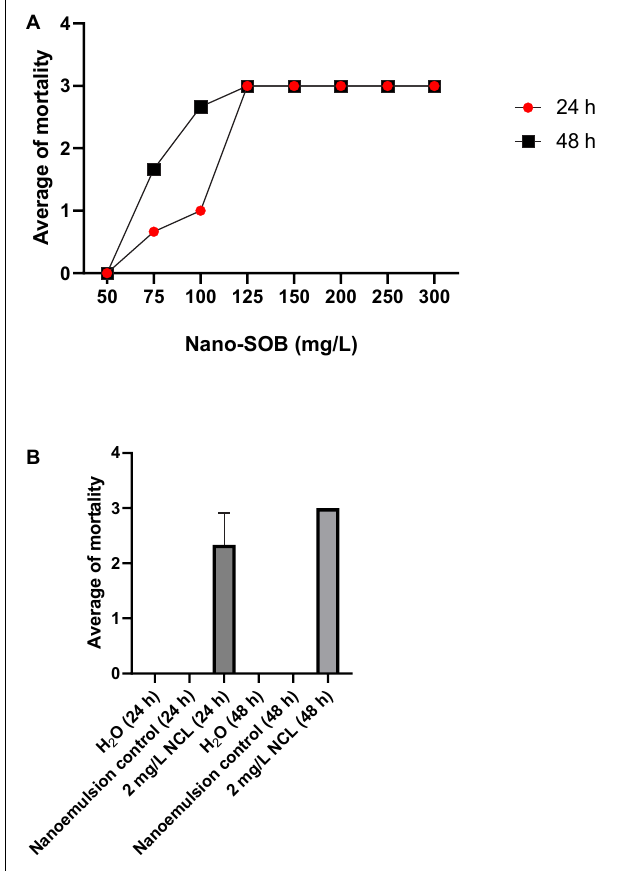
FIGURE 2 | The molluscicidal test on adult Biomphalaria glabrata for 48 h using nano-SOB (A,B) . The test was performed in triplicate on different days using 27 specimens/triplicate. These data are expressed as the mean ± SD. Using the linear regression analysis, the value of R 2 is determined as 0.852, with a P value of